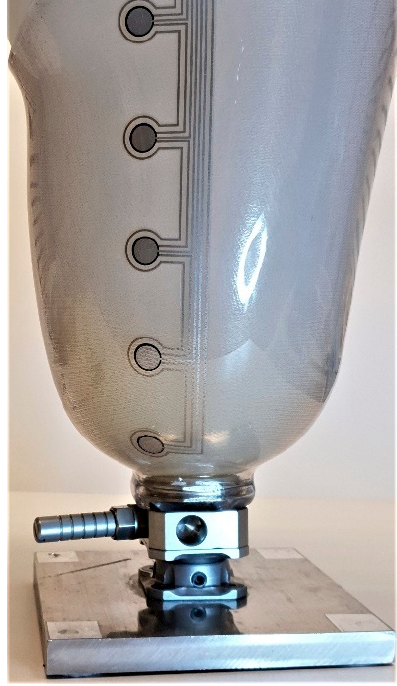
Figure 17. A QTSS™ pressure sensor inside a socket.